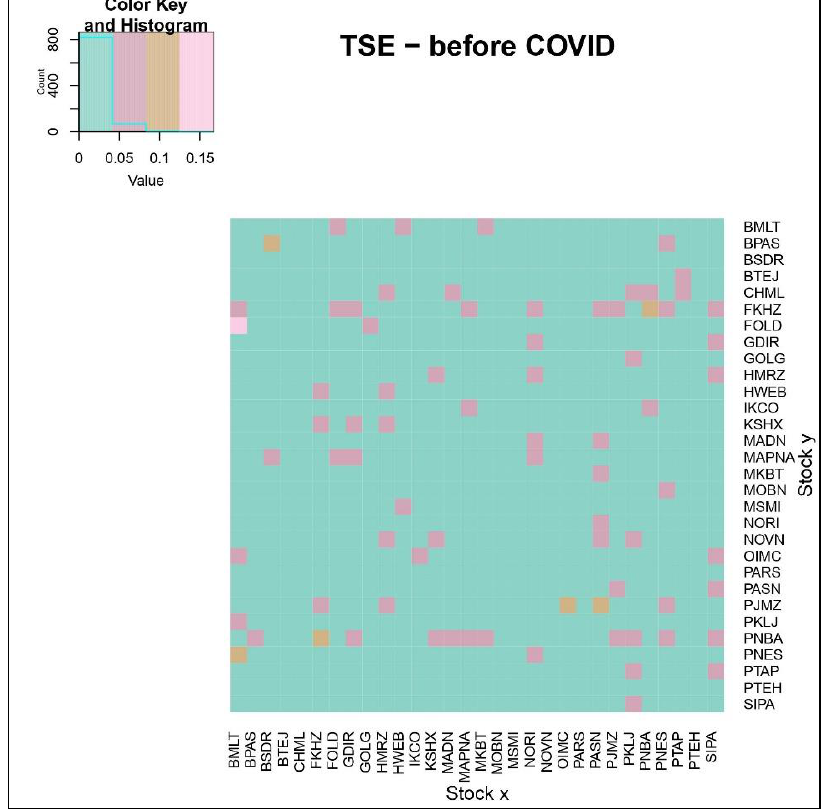
Figure 25. The information flow (effective transfer entropy) from stock y to stock x, for the top companies (by market capitalization) in the TSE market, before the COVID-19 outbreak